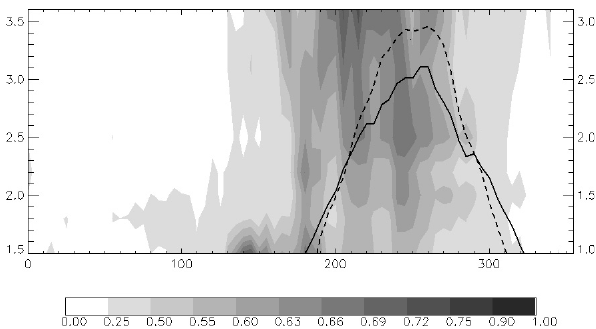
Fig. 4. Gray scale indicates the value of Pearson correlation coef- ficients between historical storm series and instrumental storm se- ries constructed using different wave height thresholds (left vertical axis), for 1958–2001 with a 90 ◦ wide window centred in the direc- tion indicated in the horizontal axis. The mean number of winter storms, depending on wind direction, is included in the right verti- cal axis and is shown by the solid line (number of historical storms) and the dashed line (number of storms with waves 3.6m high (per- centile 99) or